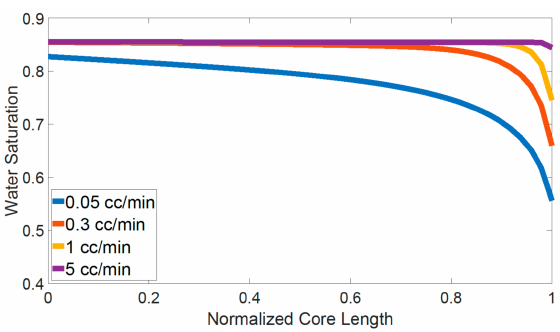
Figure 9. Water saturation profile for